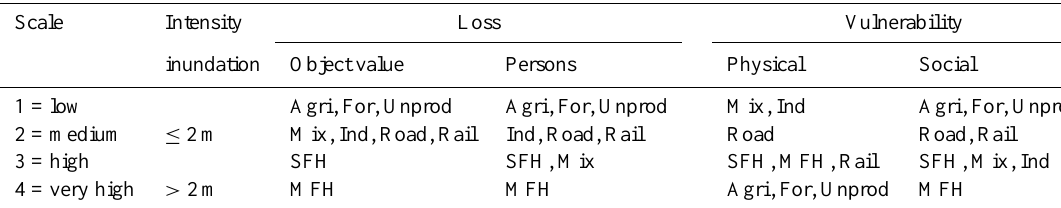
Table 2. Allocation of the assessment variables into a four-level scale. Intensity is defined by the inundation depth. Allocation of the land-use classes differs between object value and number of persons present for loss, and between physical and social vulnerability respectively. For explanation of the abbreviations see Table